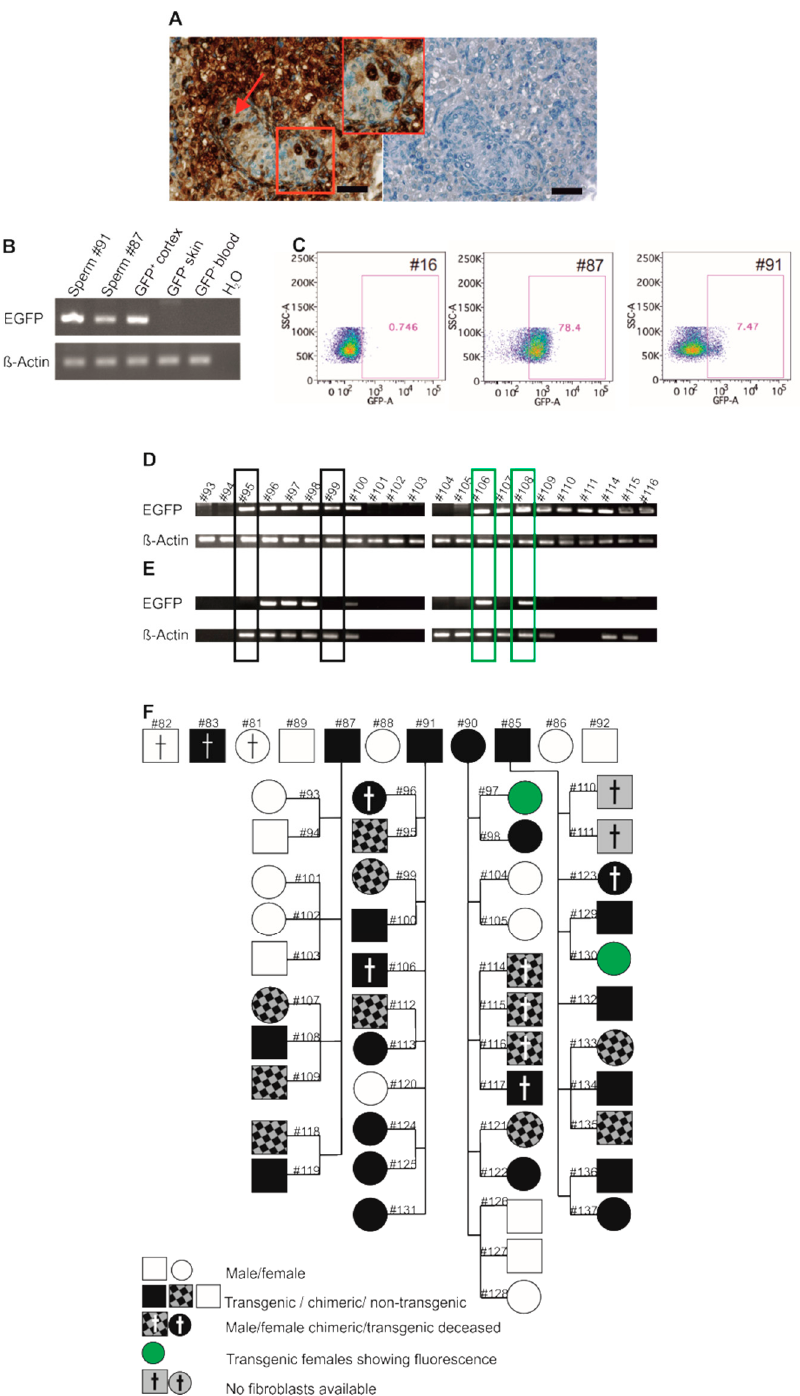
Figure 5. Germline transmission of the transgene. ( A ) Immunohistochemical detection of EGFP in the neonatal testis of #83. All germ cells show an intense EGFP signal, while intra-tubular somatic cells show only little EGFP signals. Interstitial somatic cells are strongly stained. The boxed area is shown at higher magnification (middle image in ( A )). Right image: corresponding negative (wt) control. Scale bars: 50 µ m. ( B ) EGFP PCR on genomic DNA isolated from ejaculated sperm from transgenic founders #87 and #91. Both samples show EGFP amplicons. ( C ) Flow-cytometric analysis of semen samples from transgenic founders #87 and #91 and a wt control (#16). The transgenic samples show fluorescence above background levels. ( D ) Genotyping of an exemplary subset of F1 progeny using DNA directly isolated from skin. β -Actin was used as positive control. The genotyping results